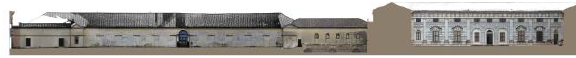
Figure 17. East façade frontage